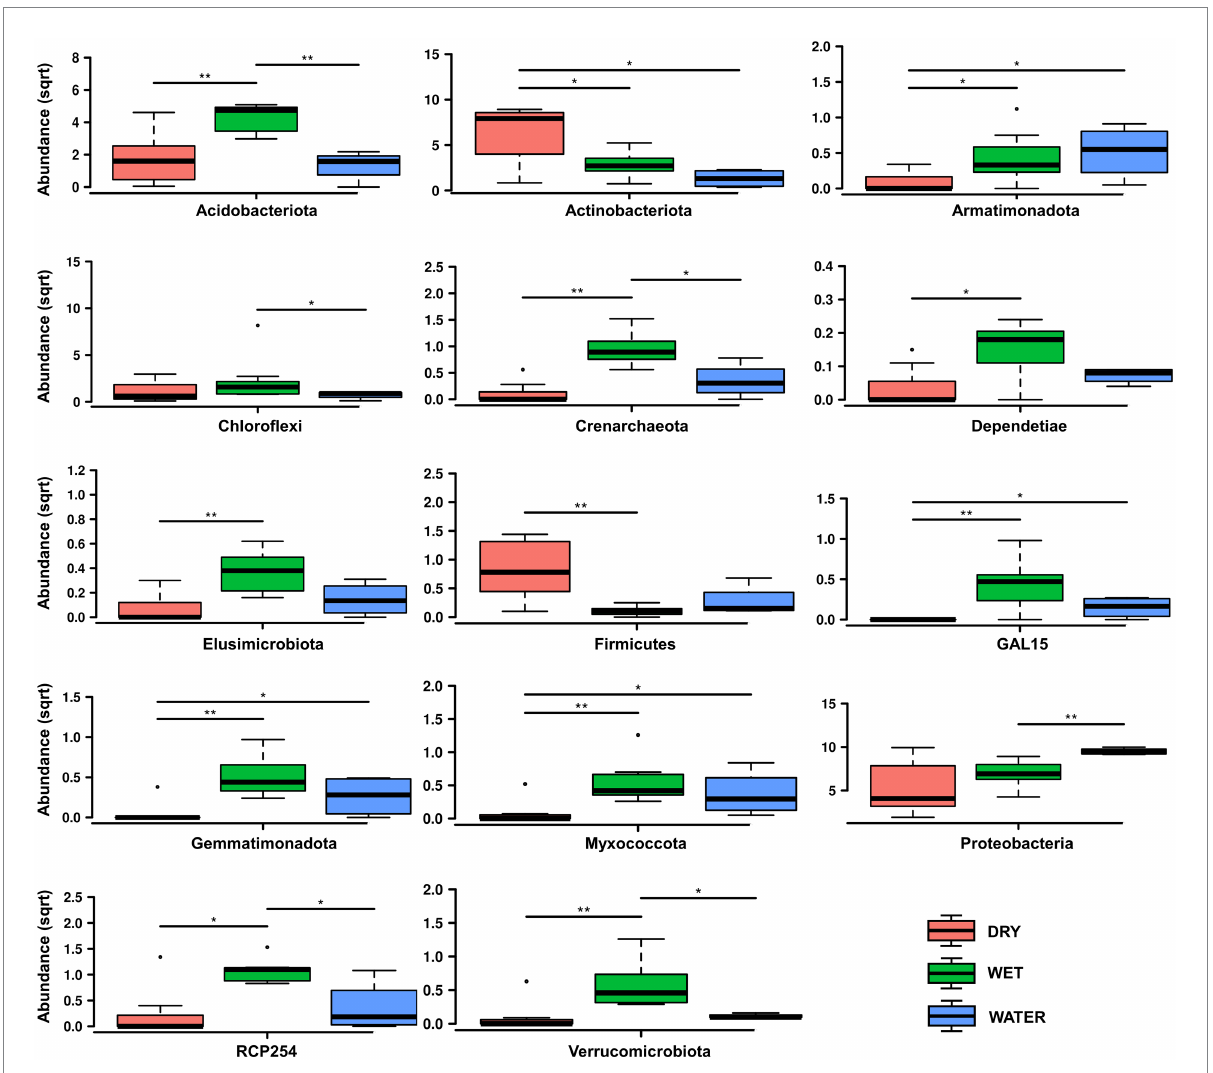
FIGURE 4 Rank test of significantly enriched microbial phyla in DRY, WET, and WATER sample groups. Abundance in the y axes stands for Relative abundance. The statistical significance is indicated by * and ** that stand for p < 0.05 and p < 0.01, respectively. (sqrt) stands for square root